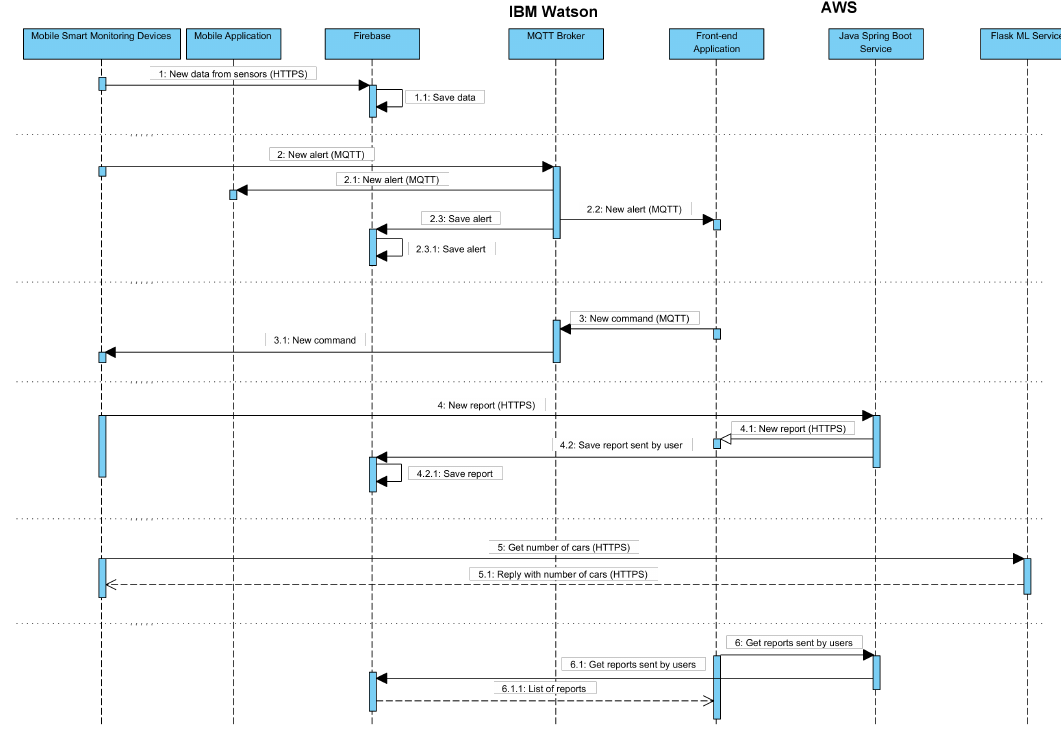
Figure 2. Sequence Diagram of all the interactions among different